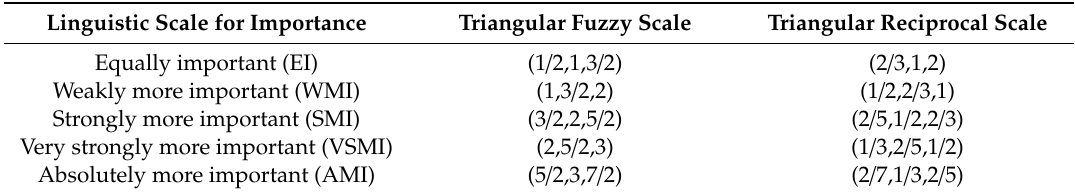
Table 2. Cheng’s fuzzy linguistic scale for importance and the corresponding triangular fuzzy numbers [45]. Linguistic Scale for